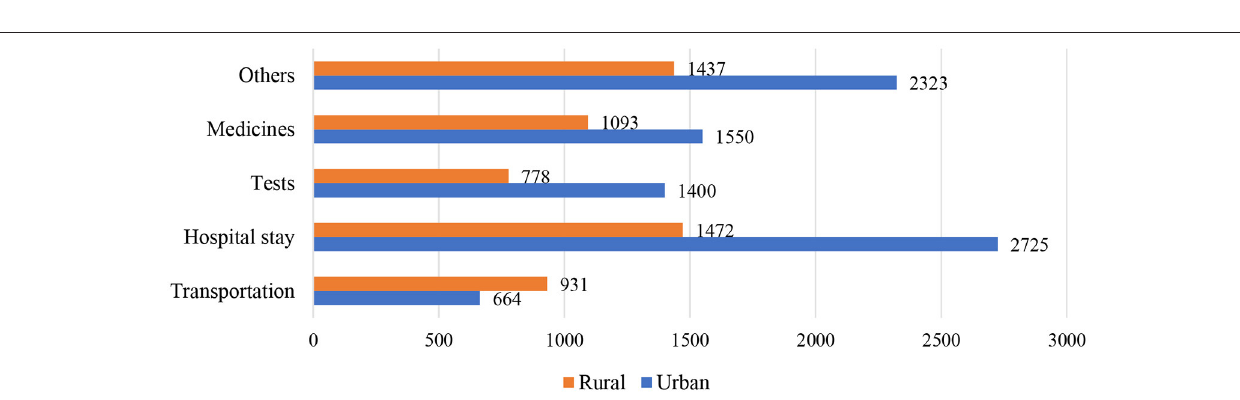
FIGURE 7 | The urban–rural difference of average out-of-pocket expenditure (in rupees) of transportation, hospital stays, tests, medicines and other costs paid for delivery of the most recent live birth among women aged 15–49 years in India and selected states,